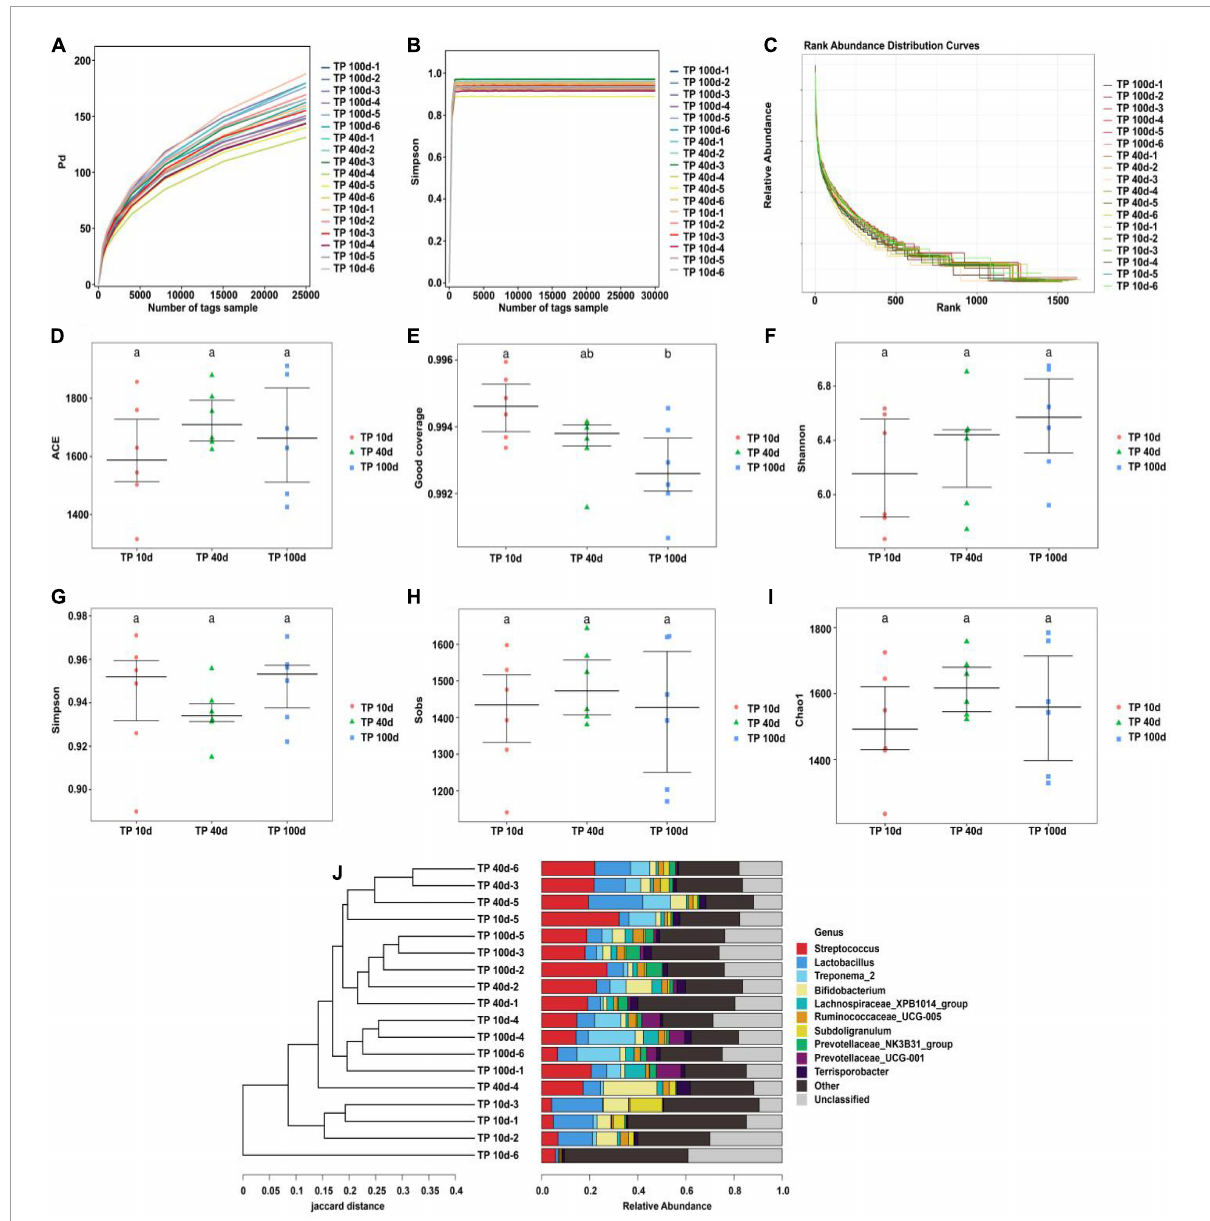
FIGURE3 Microbial diversity in colon of Tibetan pig at different growth stages. (A) PD diversity index curve. (B) Simpson diversity index curve. (C) Rank abundance curve. (D–I) Alpha diversity index (Simpson, PD, Good’s coverage, Shannon, Chao1, and ACE). (J) UPGMA cluster tree. Each curve represents a